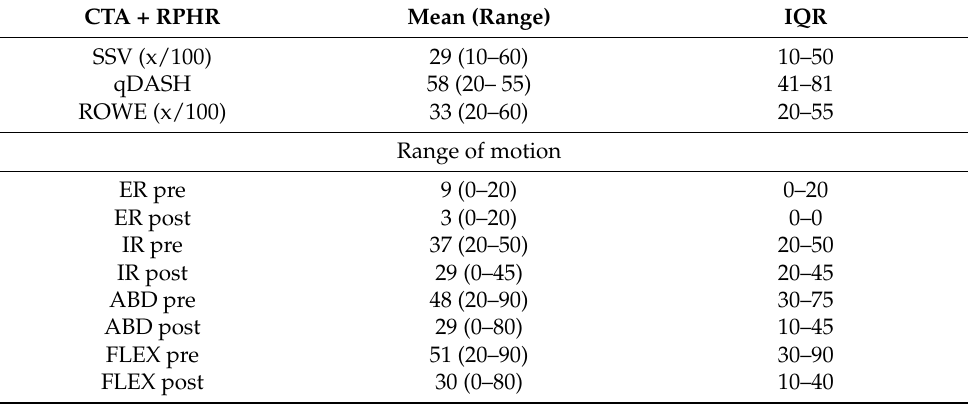
Table 6. Postoperative scores after second step of prosthesis reimplantation and range of motion (ROM) prior to prosthesis explantation (pre) and after second step prosthesis reimplantation (post) of patients revised to reverse shoulder arthroplasty (RSA). IQR: interquartile range, ER: external rotation, IR: internal rotation, ABD: abduction, FLEX: forward flexion, SSV: subjective shoulder value, qDASH: “quick” Disabilities of the Arm, Shoulder and Hand, CTA: cuff tear arthropathy, RPHR: reverse proximal humeral